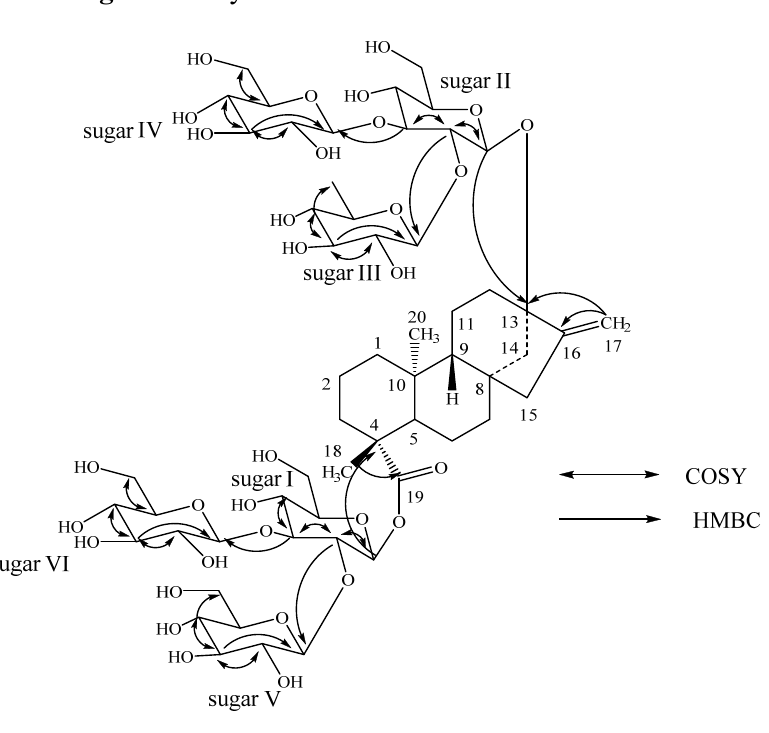
Figure 3. Key COSY and HMBC correlation of 2